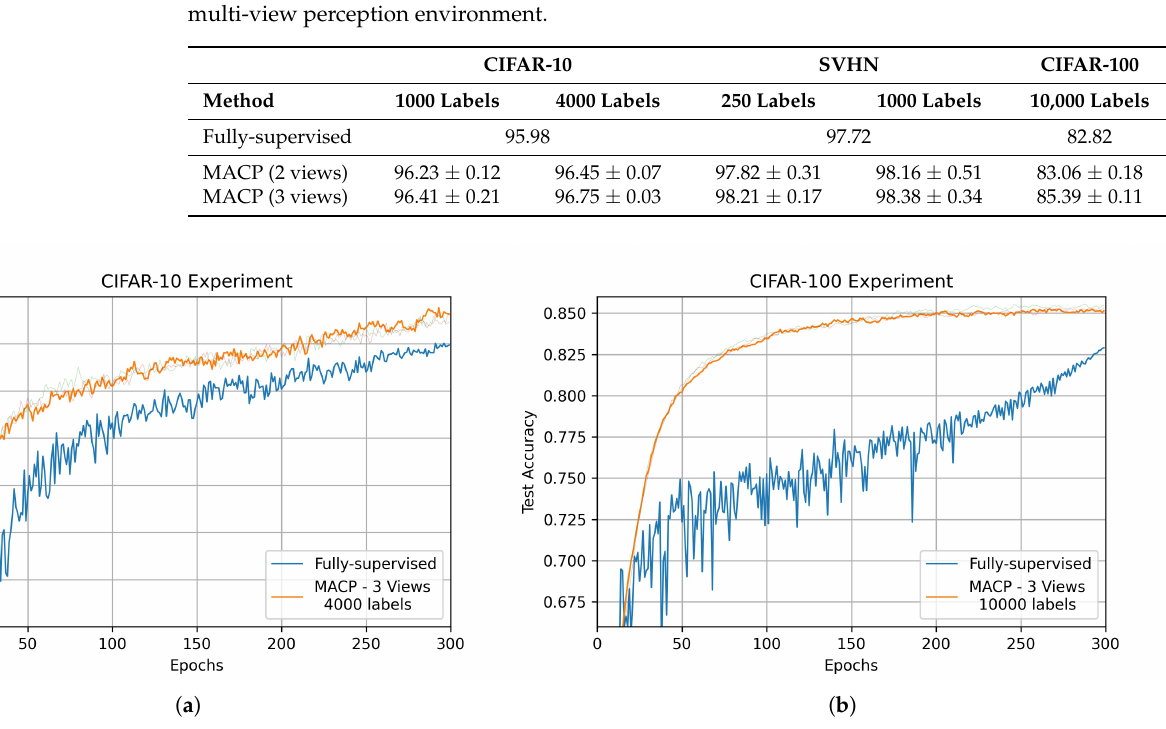
Figure 5. Performance comparison between MACP and fully-supervised method. ( a ) Performance comparison of 3-view MACP and fully-supervised method on CIFAR-10 experiment; ( b ) Performance comparison of 3-view MACP and fully-supervised method on CIFAR-100